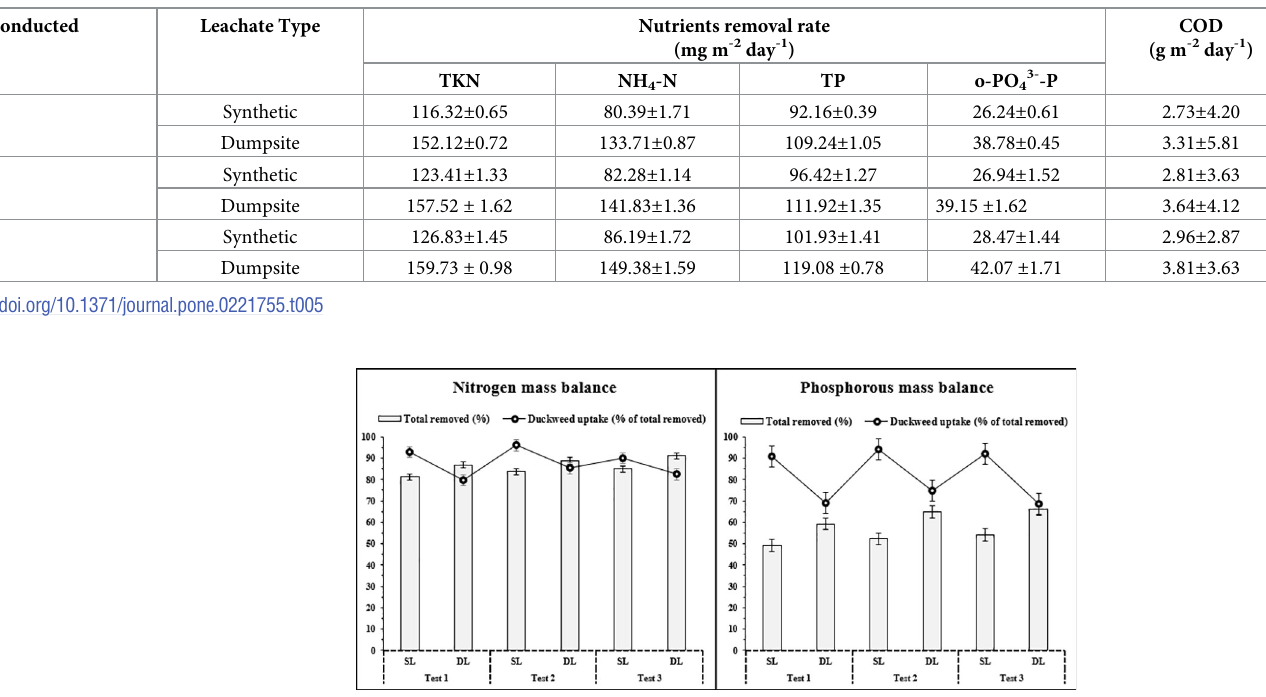
Fig 2. Comparison of mass balance of total nitrogen and phosphorous removal and uptake by duckweed from synthetic and dumpsite leachate.